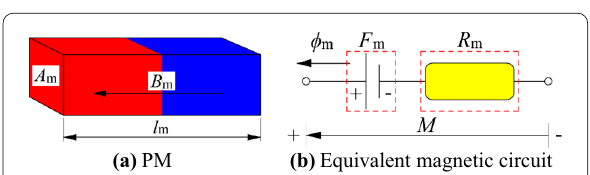
(b) Equivalent magnetic circuit Figure 6 Equivalent magnetic circuit model of PM